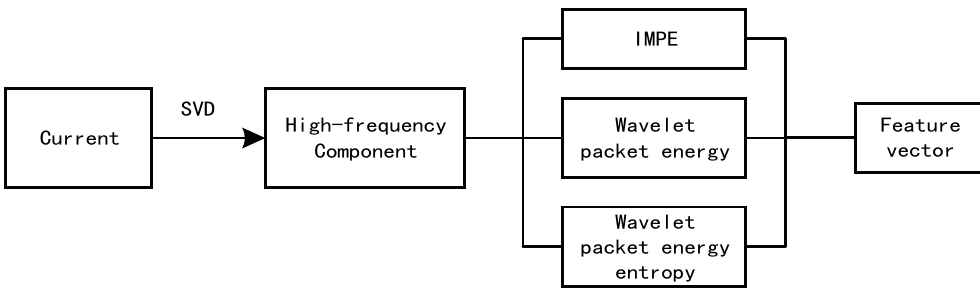
Figure 3. The process of feature extraction.